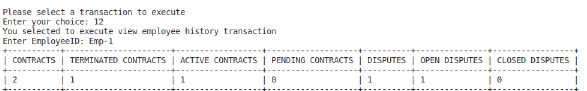
Figure 12. Showing statistics about the working history of a specific employee.